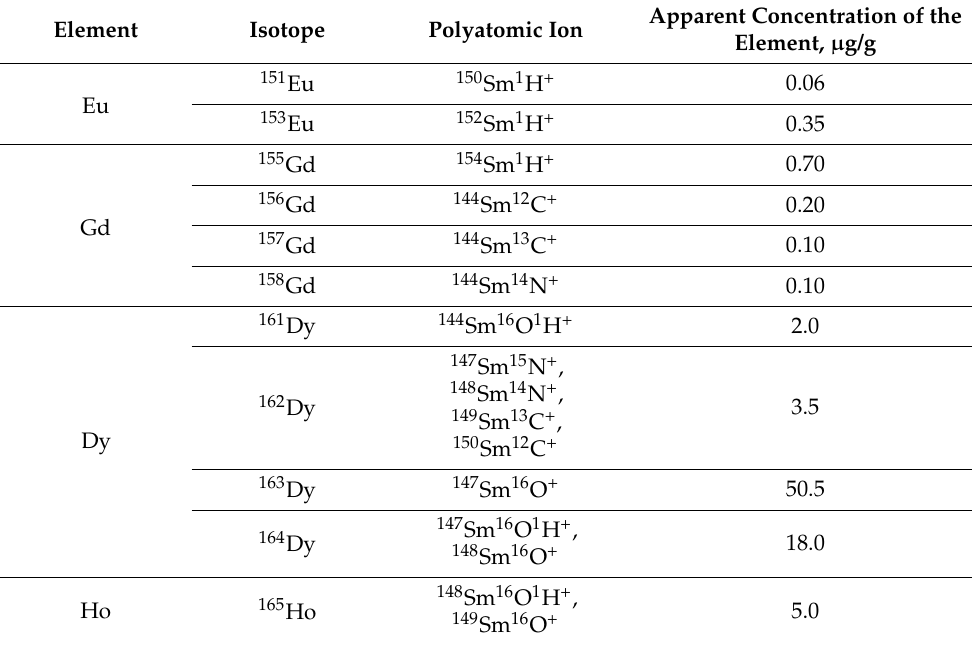
Table 5. Samarium spectral interferences for the featured